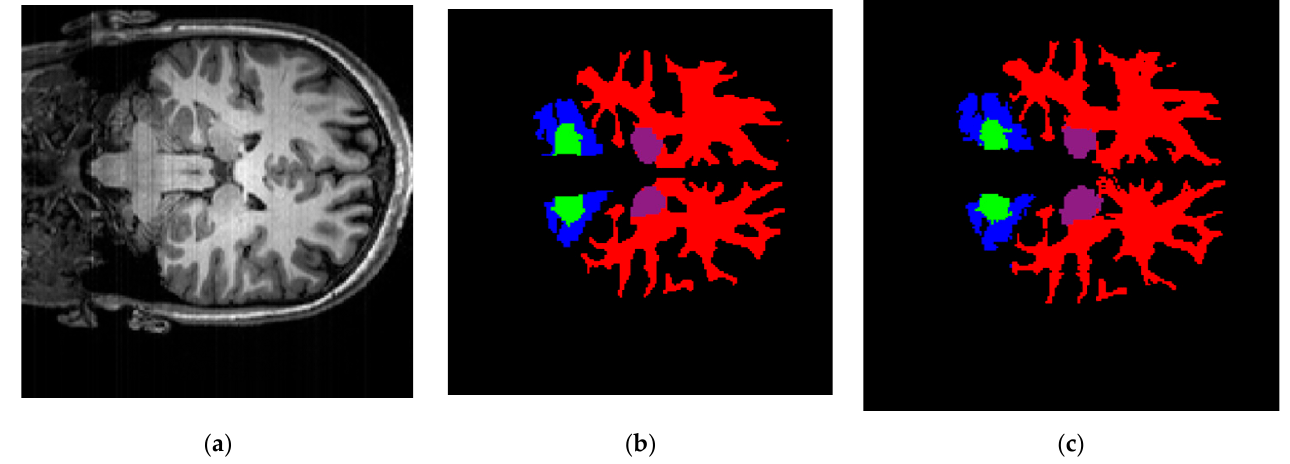
Figure 4. Segmentation results of the proposed architecture in the axial, sagittal and coronal planes where red, green, blue, purple, and yellow colors represent cerebral white matter, cerebellum white matter, cerebellum cortex, thalamus, and putamen structures, respectively. ( a ) Original MRI slide; ( b ) ground truth mask of the slide; ( c ) predicted MRI mask of the slide. Table 1. Segmentation results per brain structure in a testing MRI. Brain Structure Precision Recall